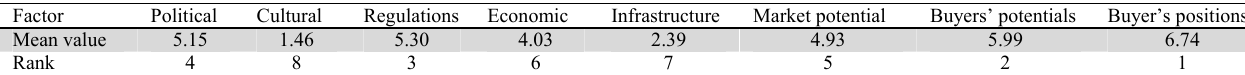
The results of Freedman